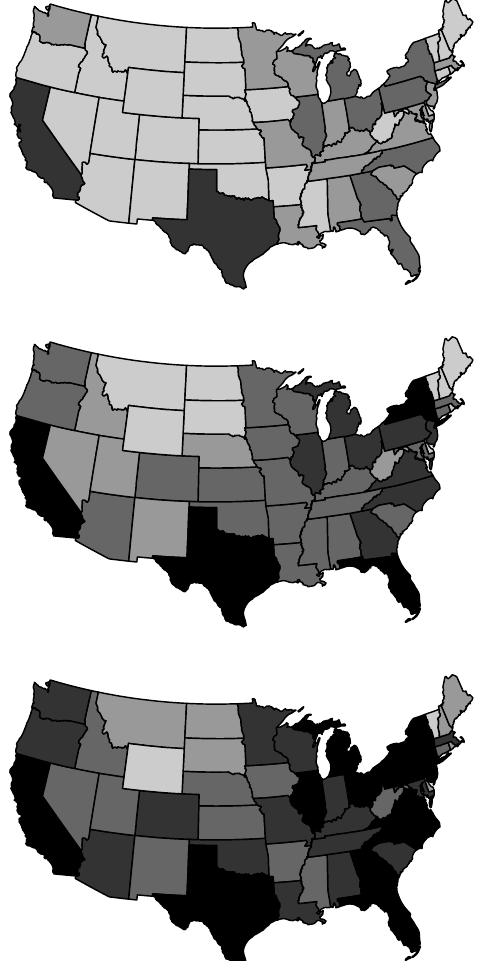
Figure 6. Maps of the total cost (in 2018 dollars) for three years: 1998 ( top ), 2008 ( middle ), 2018 ( bottom ). The intensity of darker color is associated with the higher level of the estimated cost. Five regions are created on each map based on the following grouping of the state cost in billions of dollars: < 1, 1–2, 2–5, 5–10 and >